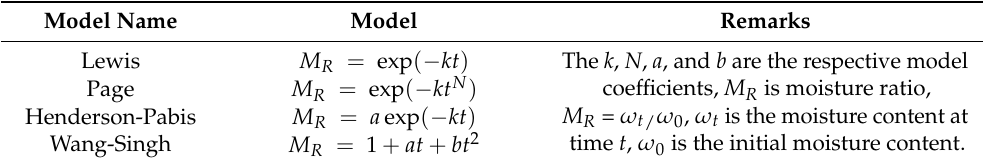
Table 4. Mathematical model of drying dynamics.